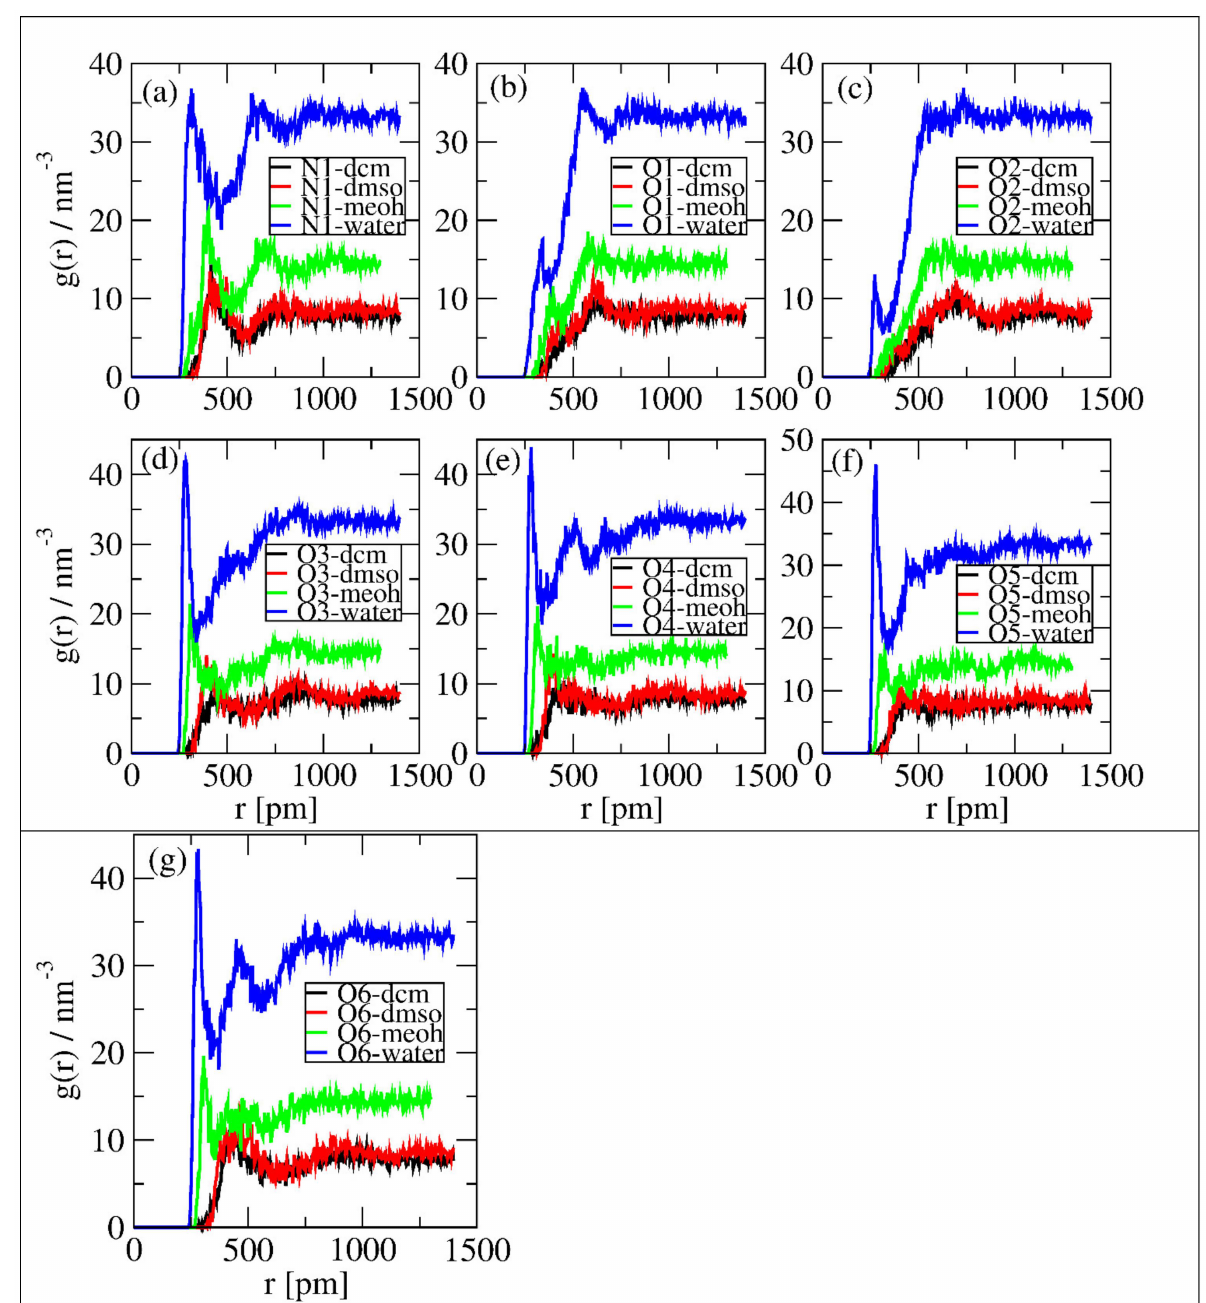
Figure 6. Local density of polar atoms around linamarin and centres of mass of solvents correspond to ( a ) N1, ( b ) O1, ( c ) O2, ( d ) O3, ( e ) O4, ( f ) O5 and ( g )